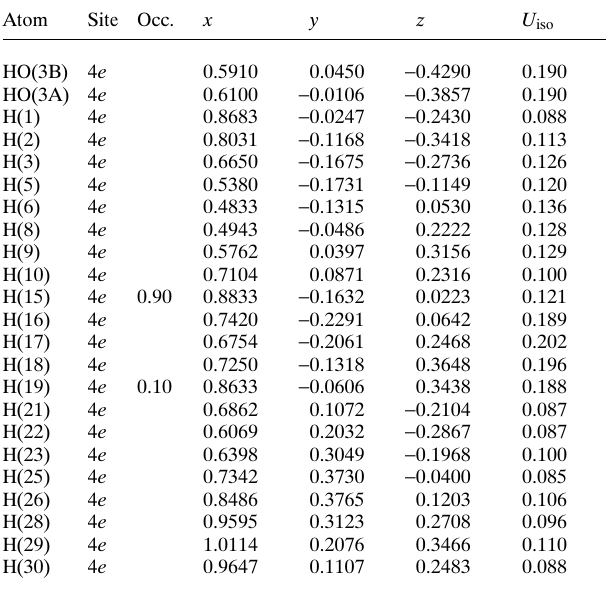
Table 2. Atomic coordinates and displacement parameters (in Å 2 ) .